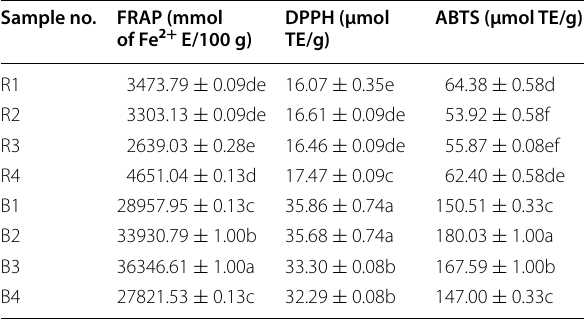
Data were expressed as mean same column marked with different small case letters were significantly ( p < .05)